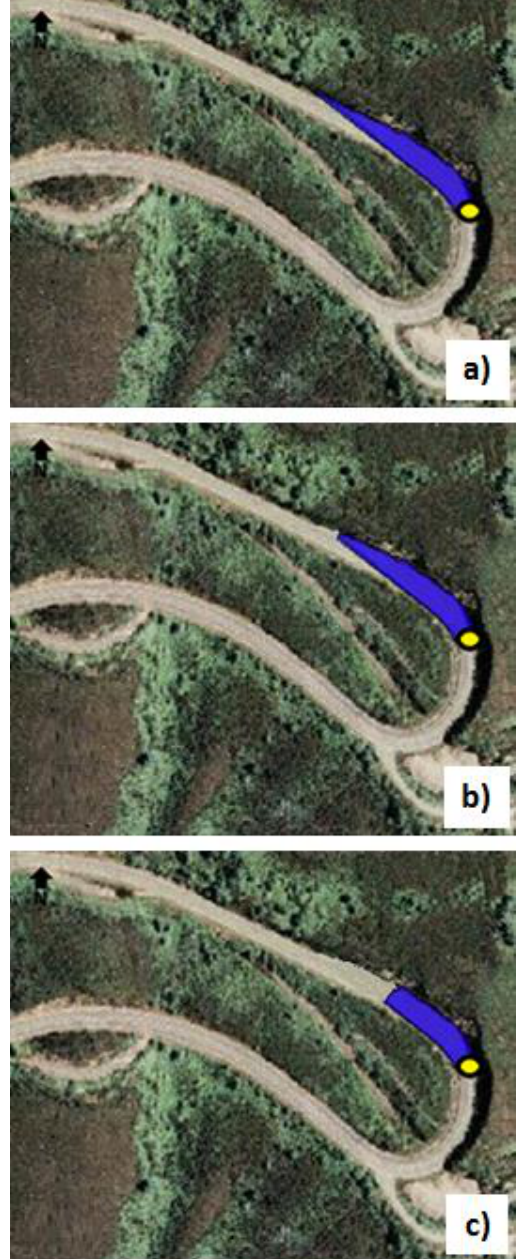
Figure 11. Case study 2. Visibility diagram in the inter urban road between Ourense and Castro Caldelas. Yellow circle indicates the car position. Visibility range: a) 150 m (fog), b) 100 m (dense fog), and c) 50 m (ultra dense